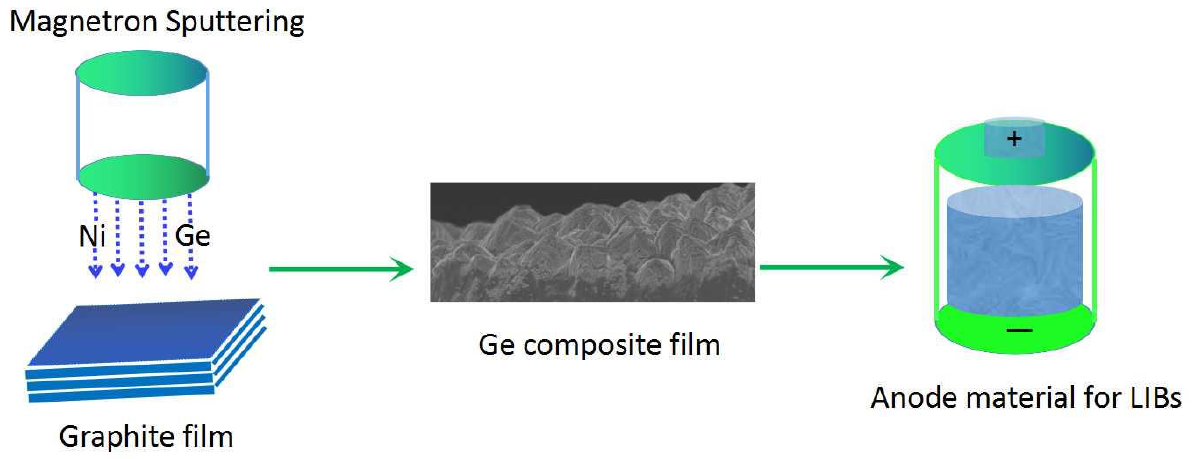
Figure 2. Schematic illustration of the fabrication process of the pyramid-patterned Ge film anode by magnetron sputtering.